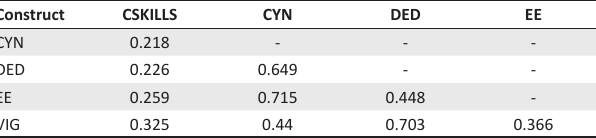
TABLE 6: Heterotrait-monotrait ratio of correlations (second-order construct and the dependent variables). Construct